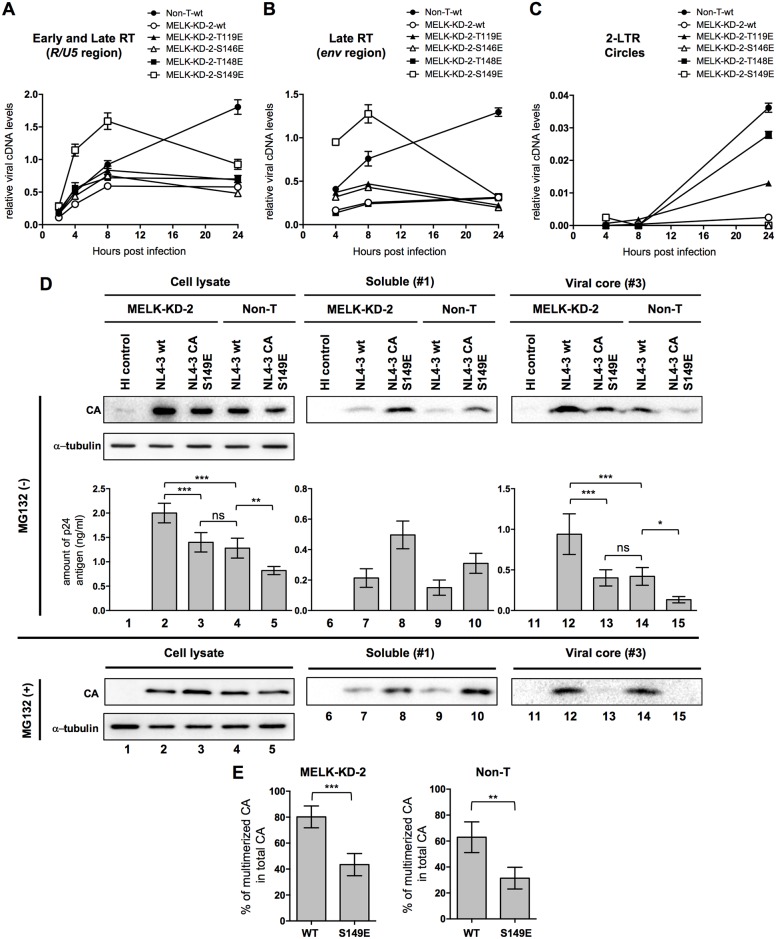
Phosphorylation of Ser-149 in CA regulates CA disassembly and viral cDNA synthesis in human T cells.(A-C) Quantitative DNA-PCR analyses of viral cDNA metabolism after HIV-1 infection of MT4C5 cells. Total DNA was extracted from non-target shRNA (Non-T) or MELK-depleted (MELK-KD-2) MT4C5 cells at the indicated time points (2, 4, 8 and 24 h) after infection with wild-type or the indicated mutants of HIV-1 and analyzed for the amounts of the R/U5 region as early viral cDNA (A), the env region as late viral cDNA (B) and the 2-LTR circle form (C). Experiments were performed at least three times and error bars are standard deviations calculated from three independent experiments. The ratios of each viral cDNA level to beta-globin DNA level are given. (D) Fate-of-capsid assays with non-target shRNA (Non-T) or MELK-KD-2 MT4C5 cells infected with NL4-3 or its S149E CA mutant for 8 h in the presence or absence of 10 μM MG132 (MG132 [+] or MG132 [–]). HIV-1 stock inactivated by incubation at 65°C for 30 min was used as a negative control (HI control). Cell lysates were prepared and analyzed as in Fig 2I. Aliquots of input, fraction #1 and #3 were processed for immunoblotting with anti-p24 antibody (CA). The amount of CA in each fraction in the absence of MG132 was quantified by HIV-1 p24 ELISA (MG132 [–], lower panels). Experiments were performed five times and one representative set of data is shown. (E) Percentages of pelletable CA (fraction #3) within total CA in the absence of MG132 were calculated based on the p24 ELISA data shown in Fig 4D. Total CA denotes the sum of the amount of p24 antigen which was calculated based on the p24 ELISA data of fractions #1, #2, and #3. Error bars represent the standard deviations calculated from five independent experiments. Statistical significance was determined by one-way analysis of variance (ANOVA) with Tukey’s multiple comparison test (D), or unpaired two-tailed Student’s t test (E). ns, not significant (P>0.05); *P<0.05, **P<0.01, ***P<0.001.